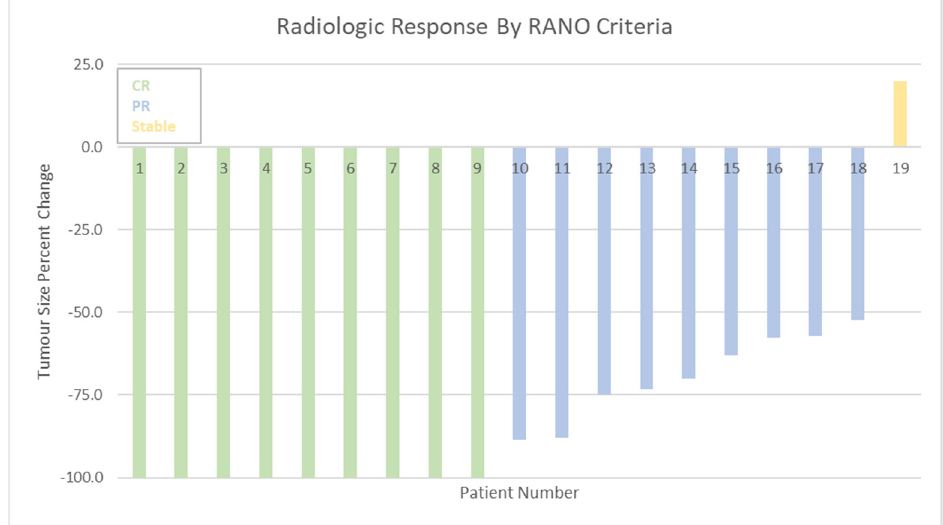
Figure 2. Response rates as per RANO criteria. RANO = Response Assessment in Neuro-Oncology. CR = complete response. PR = partial response. Stable = stable